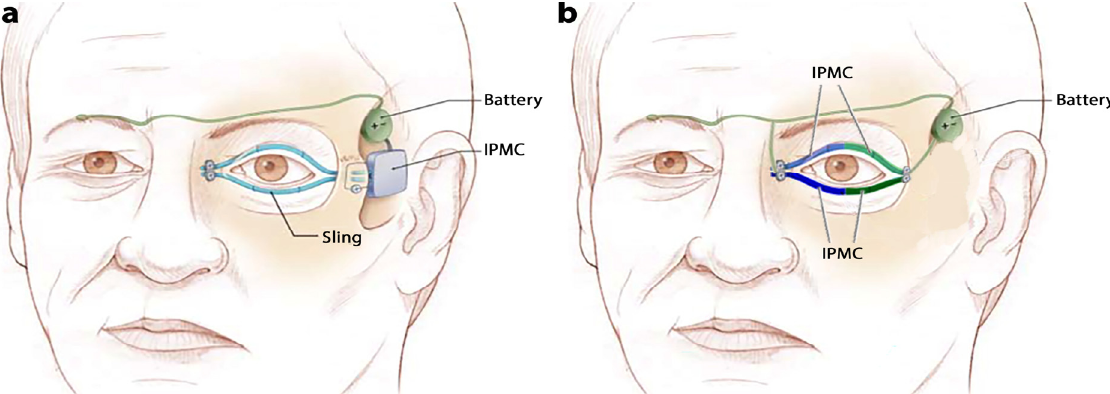
Figure 1. ( a , b ) show the schematic mechanisms of models A and B, respectively. Original (panel ( a )) and modified (panel ( b )) images were used with permission from the work of Ledgerwood and Tollefson et al., “Artificial Muscle for Reanimation of the Paralyzed Face” Arch Facial Plast Surg. 2012; 14(6):413–418) [9]. Table 1. Material properties of electrodes, membrane, and basic polymer.